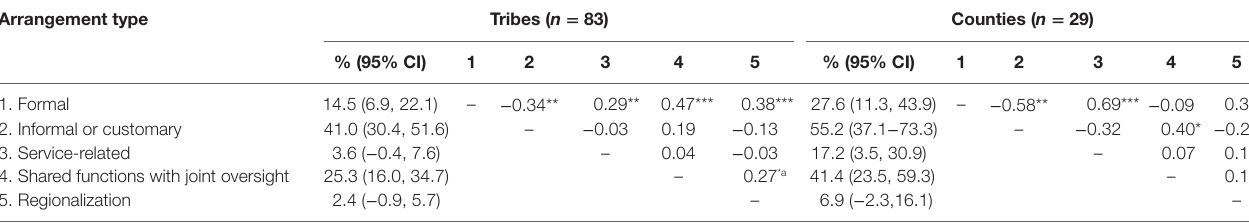
Table 1 | Frequencies and intercorrelations between CJS arrangement